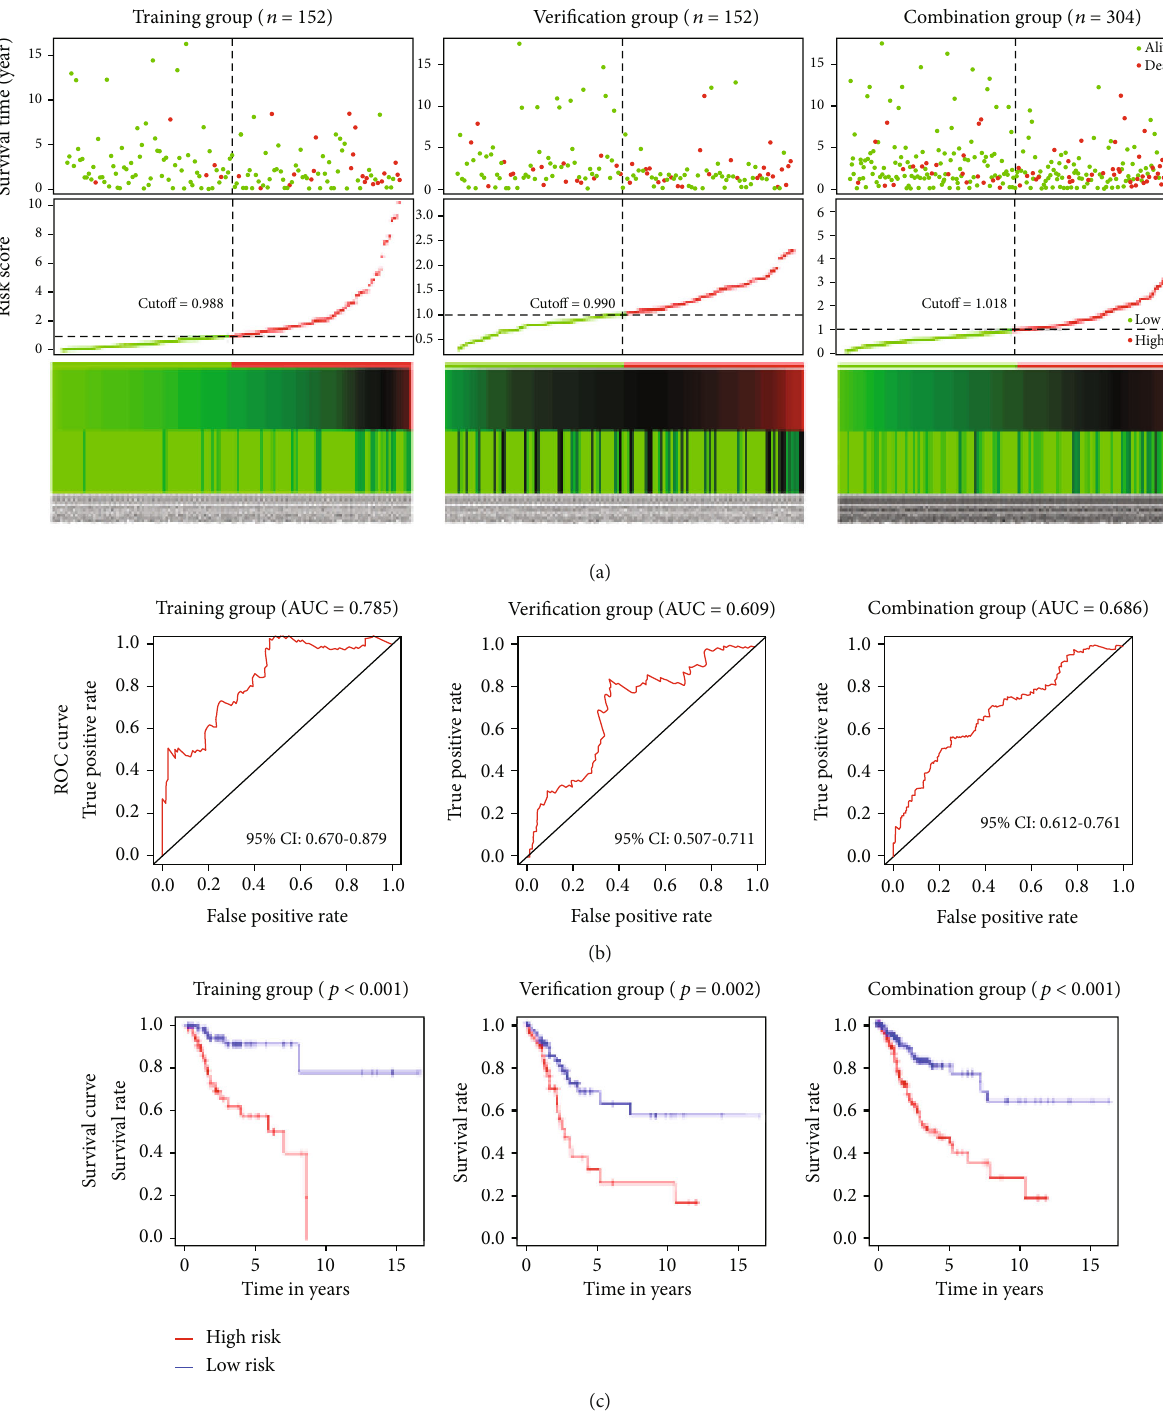
Figure 5: Construction of a four-gene prognostic signature for CC. (a) Survival status of patients with CC and four-gene signature risk score distribution for the training, veri fi cation, and combination groups. The black-dotted line represents the median cuto ff . (b) AUC of the ROC curve evaluating the ability of the four-gene signature to predict prognosis in terms of OS. (c) Kaplan-Meier curves of the four-gene signature indicating that high-risk patients had shorter survival than low-risk patients. AUC: area under the curve; CC: cervical cancer; CI: con fi dence interval; OS: overall survival; ROC: receiver operating